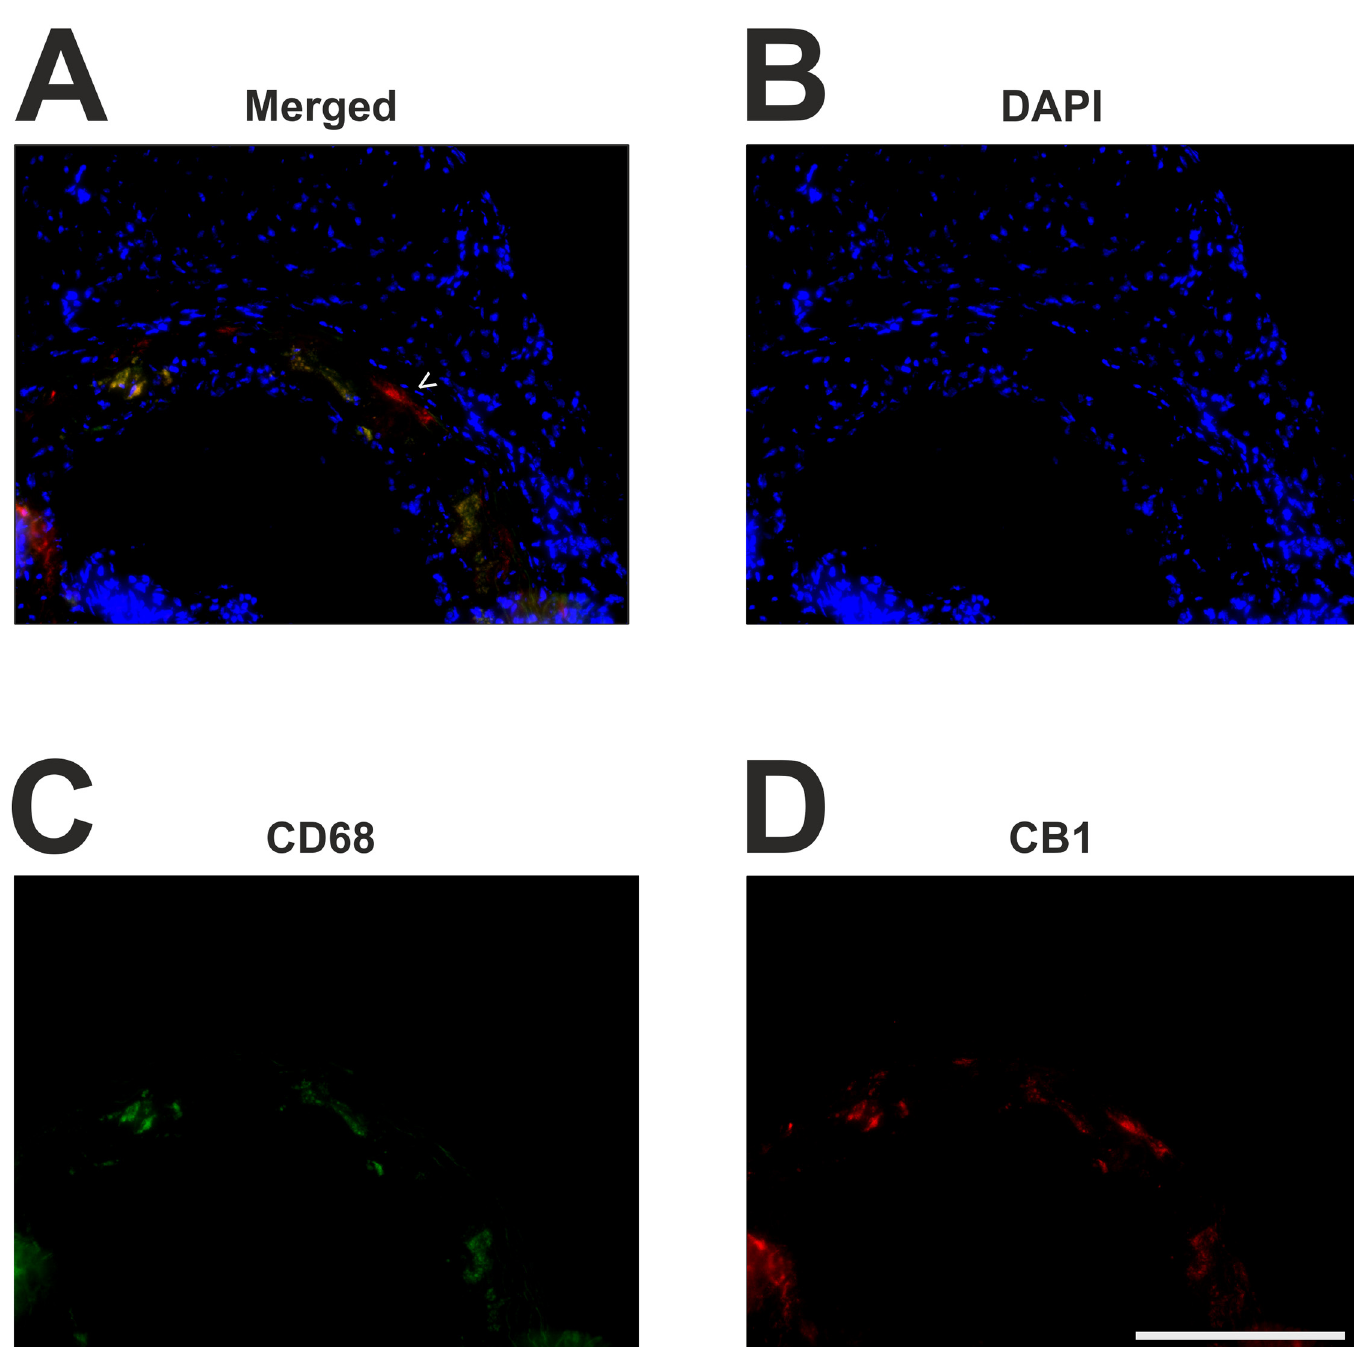
Fig 4. Immunofluorescent costaining of CB1 and CD68. Frozen sections through the aortic sinus were stained for CD68 and CB1 using Cy2 (green, C) and Cy3 (red, D) fluorochroms. Nuclei are stained with DAPI (blue, B). Lesional CD68-positive monocytes and macrophages (C) are the main contributors to lesional CB1 receptor expression (D) Very few cells express CB1 which do not express CD68 (arrow head, A). Scale bar, 200 μ m. CB1, cannabinoid receptor 1; CD68, cluster of differentiation 68; DAPI, 2-(4-amidinophenyl)-6-indolecarbamidine dihydrochloride.